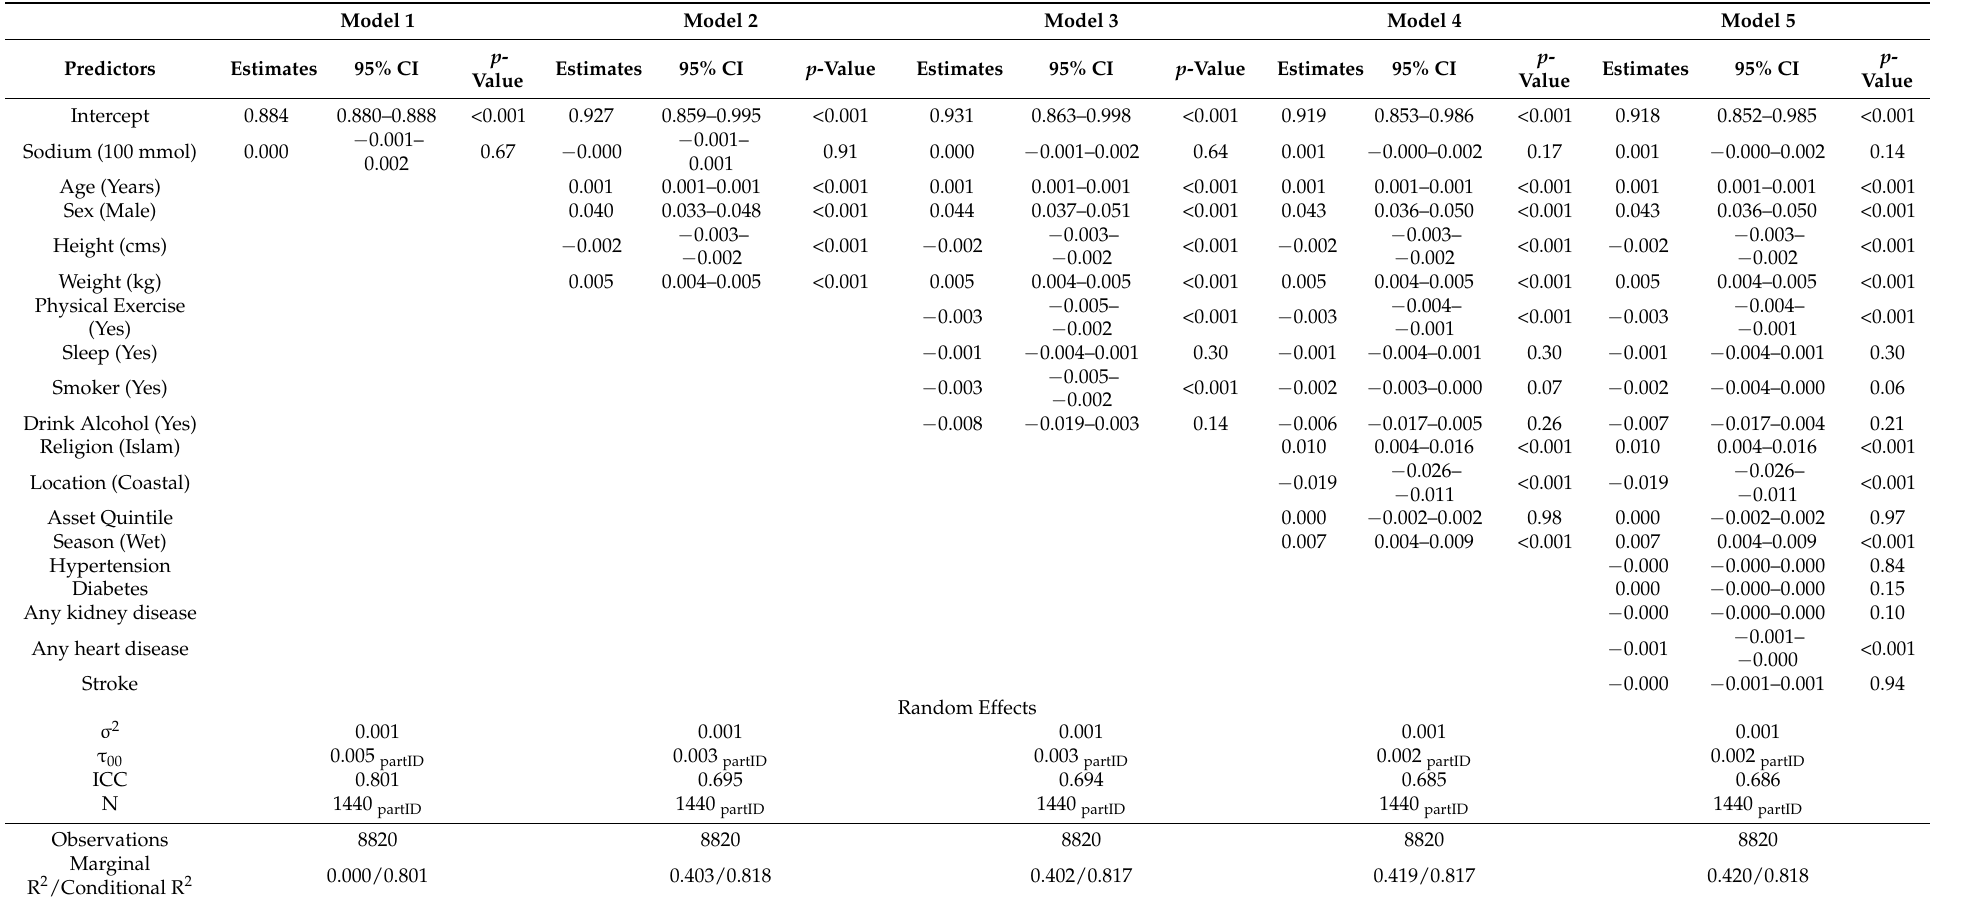
Table 4. Association between 24 h urinary sodium and mean waist-to-hip